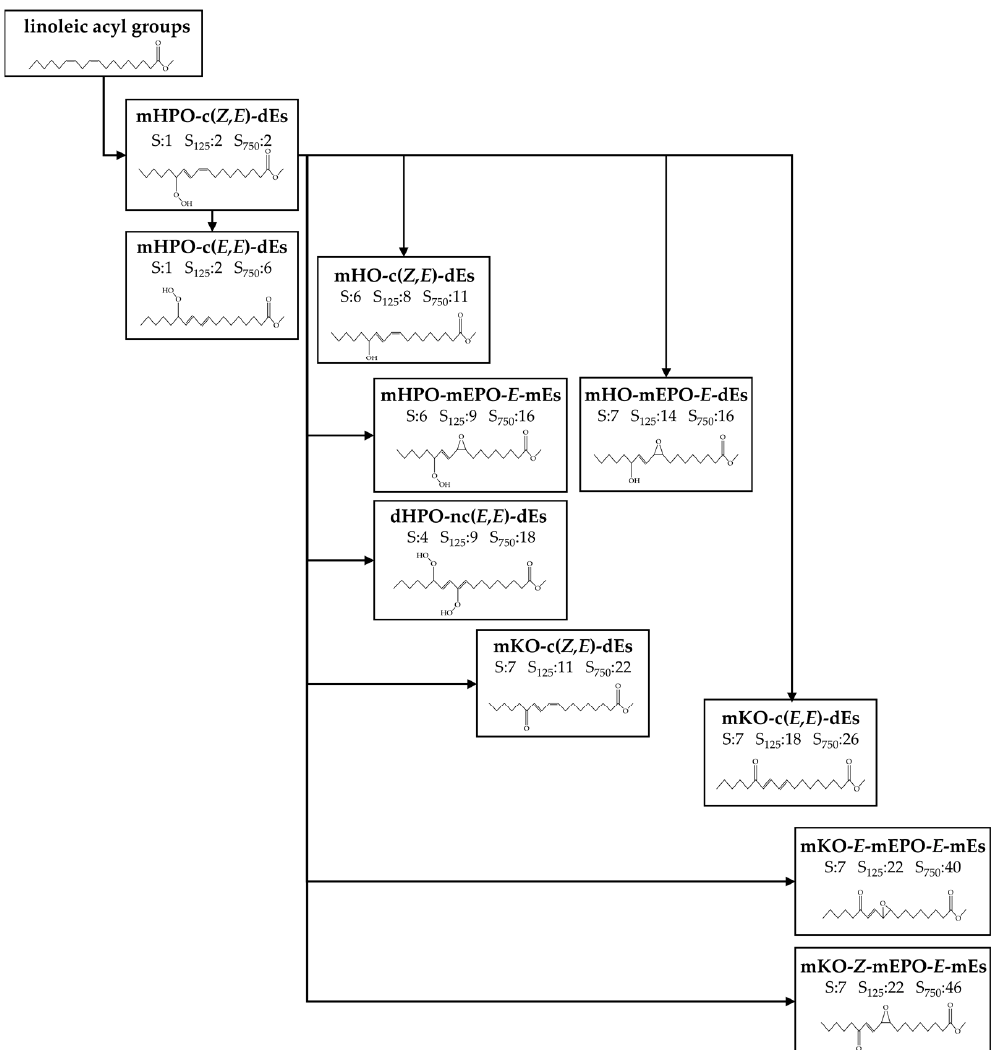
Figure 5. Long-chain oxylipins that have their origin in the peroxidation of the acyl linoleic group, with an indication of their potential precursor according to some authors [44–47], ordered from left to right and from top to bottom according to the beginning of their formation in samples S 125 and S 750 respectively.